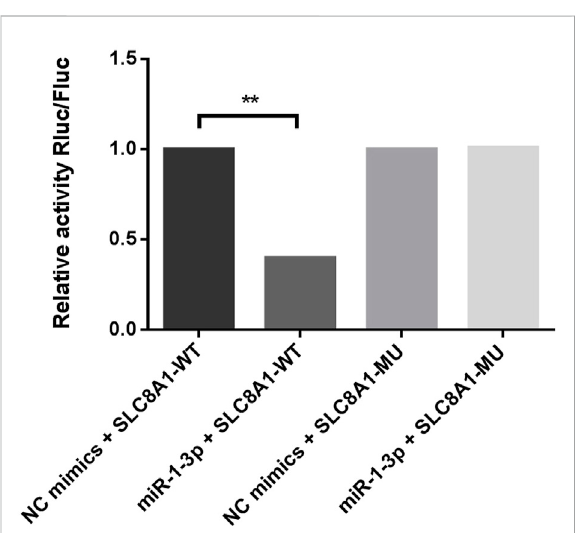
FIGURE 6 Dual luciferase reporter assay veri fi es that SLC8A1 is